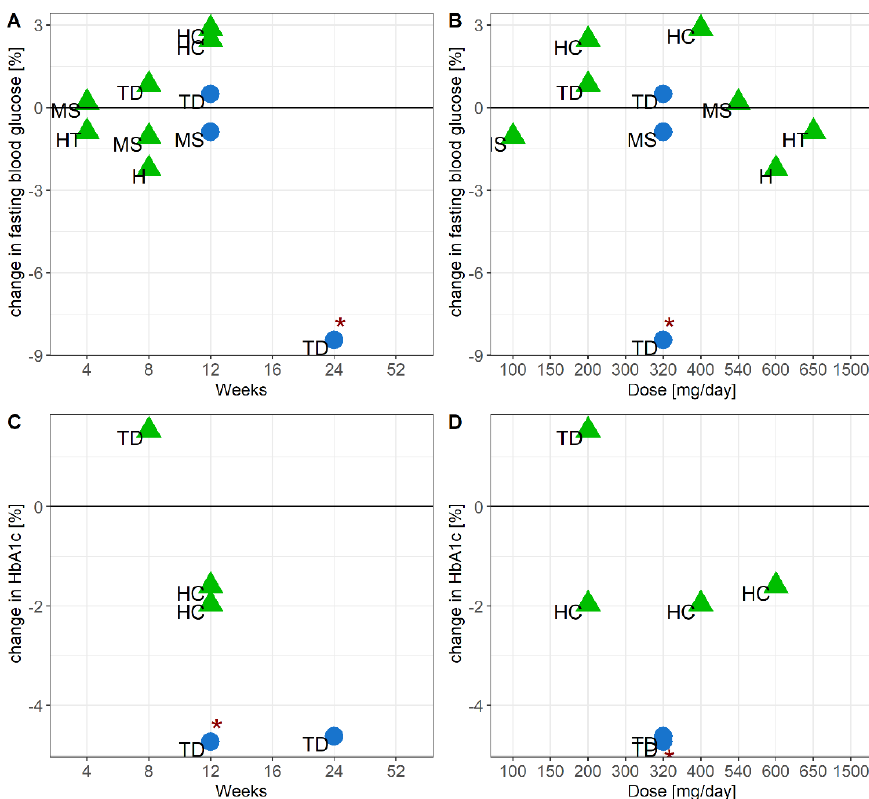
Figure 4. Relationship between the average change in fasting blood glucose and study duration ( A ), or dose ( B ), and between the average change in HbA1c levels and study duration ( C ), or dose ( D ). ● = bilberry and blackcurrant extract (blue), ▲ = grape seed extract (green), study population: H = healthy, HC = hypercholesterolemia, HT = hypertension, MS = metabolic syndrome, TD = Type 2 Diabetes Mellitus. * published p -value < 0.05.